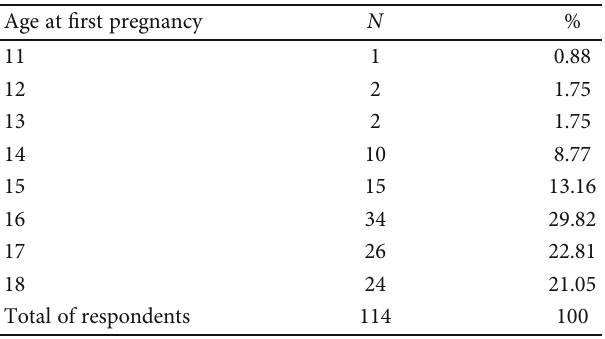
Figure 1: Correlation between the age at menarche and age at fi rst sexual intercourse of adolescents attended at a Basic Health Unit (age at menarche × age at fi rst Table 1: Distribution of the age at the fi rst pregnancy of adolescents attended at a Basic Health Unit.